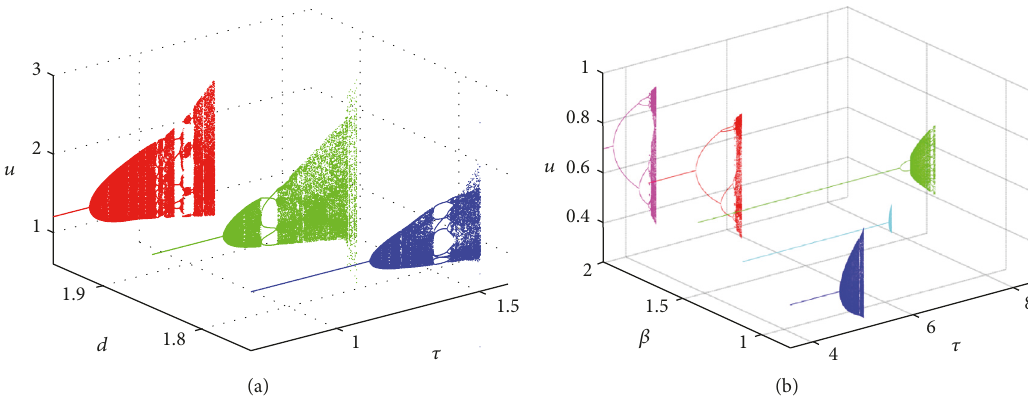
Figure 11: Bifurcation diagrams in (𝜏, 𝑑,𝑢) space and (𝜏, 𝛽,𝑢) space, describing (a) the change of Neimark-Sacker bifurcation when 𝑎 = 2 , 𝑏 = 2 , 𝑐 = 2 , 𝛼 = 0.1 , 𝛽 = 0.1 , and 𝑑 = 1.75 , 1.85, and 1.95 and (b) the transition between Neimark-Sacker bifurcation and flip bifurcation when 𝑎 = 1 , 𝑏 = 2 , 𝑐 = 0.2 , 𝑑 = 1 , 𝛼 = 1 , and 𝛽 = 0.8 , 1.1, 1.3851, 1.7, and 2.